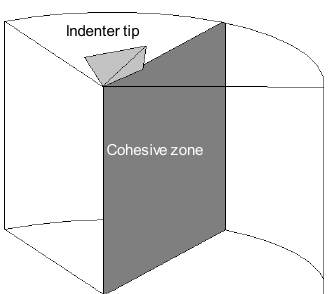
Fig. 7 Schematic of the geometry of the 3D FEM crack model.